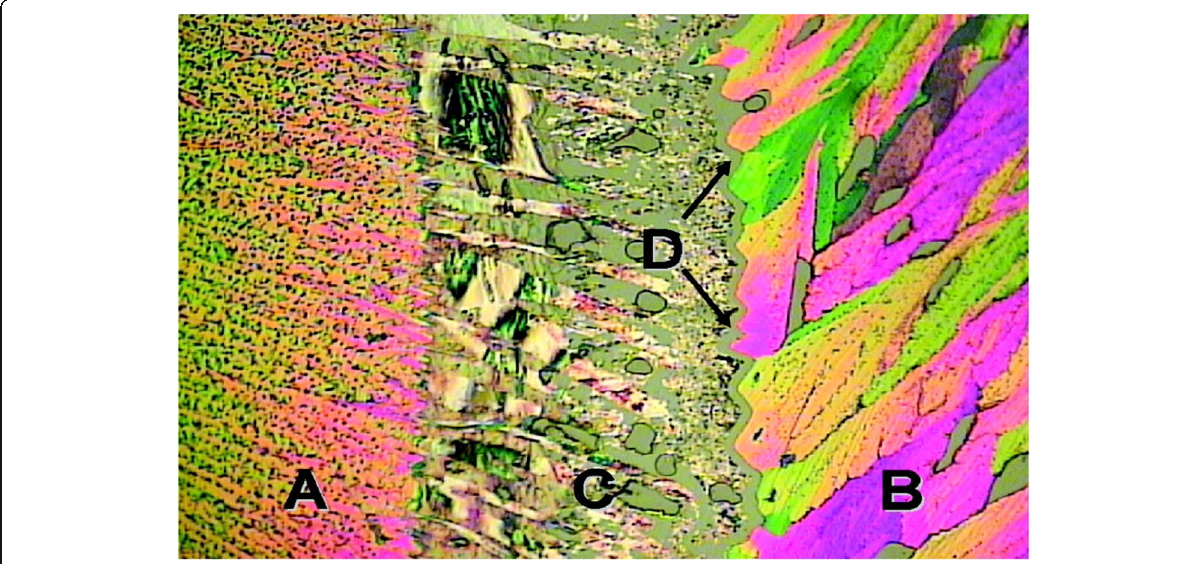
Fig. 7 HSM micrographs of Lamotrigine and Phthalimide cocrystal screening a phthalimide, b Lamotrigine, c cocrystals, d melting of cocrystals. Reprinted from Lek š i ć et al. 2012 with permission from the